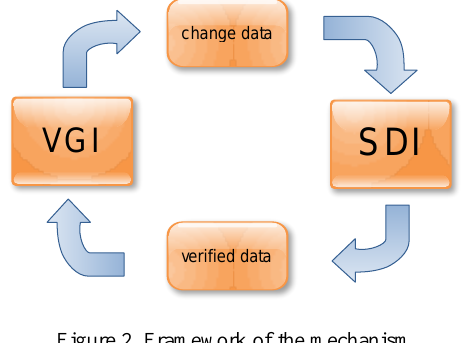
Figure 2. Framework of the